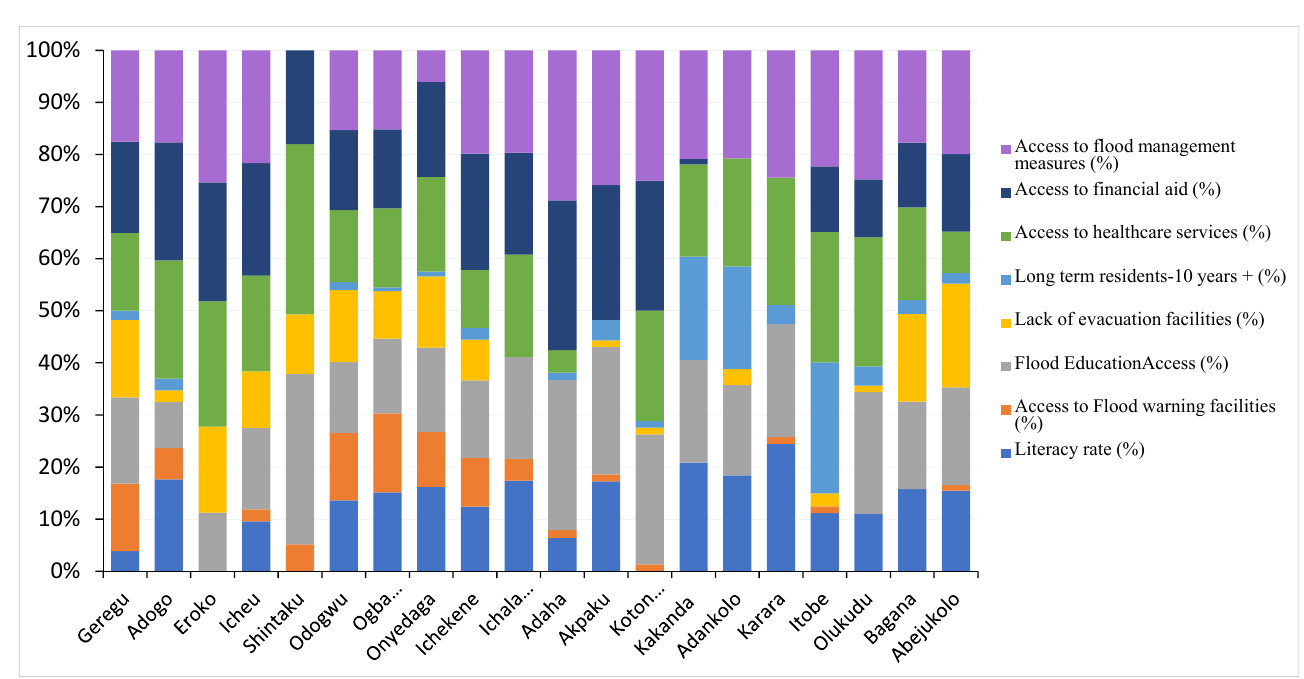
Figure 8. Contribution of the single indicator to the sub-index lack of resilience ( SILoR ) for the different selected flood-prone communities in Kogi State.